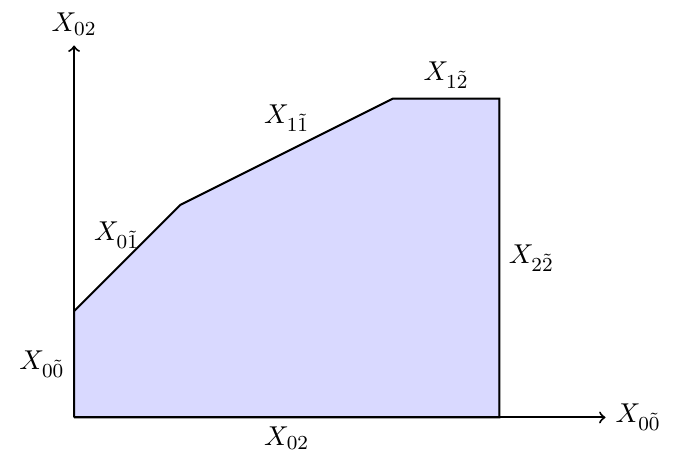
Figure 2 . The 2-dimensional kinematic cyclohedron W 2 after taking c 02 = c 0~0 = c 0~1 = c 1~1 = 1. where the factor 2 arises form